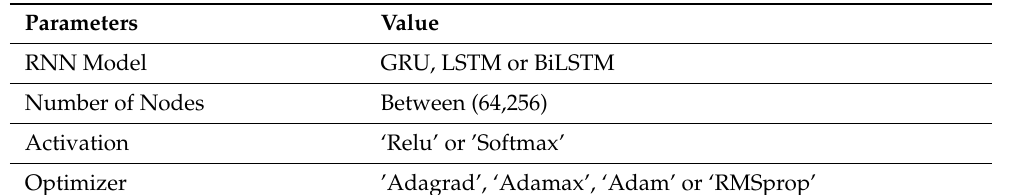
Table 1. Model layer’s